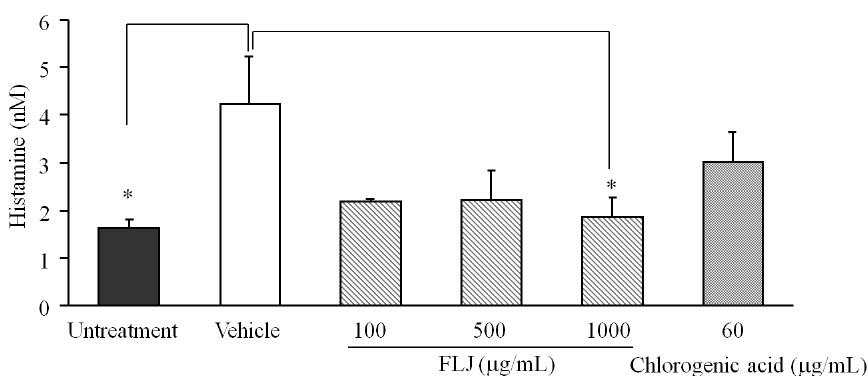
Figure 3. Effects of the FLJ extract (1,000 µg/mL) and chlorogenic acid (60 µg/mL) on the HDC expression of the three-dimensional human keratinocyte treated with 1% SL. ( A ) Detected by western blotting analysis; ( B ) The β -actin levels were evaluated as a loading control, and the data are expressed as the 74-kDa or 53-kDa HDC/ β -actin ratio. A solid line denotes the naive level (untreated). Values represent the means ± SEM ( n = 3). * p < 0.05, ** p < 0.01 vs. Vehicle treated with distilled water (Bonferroni’s test).